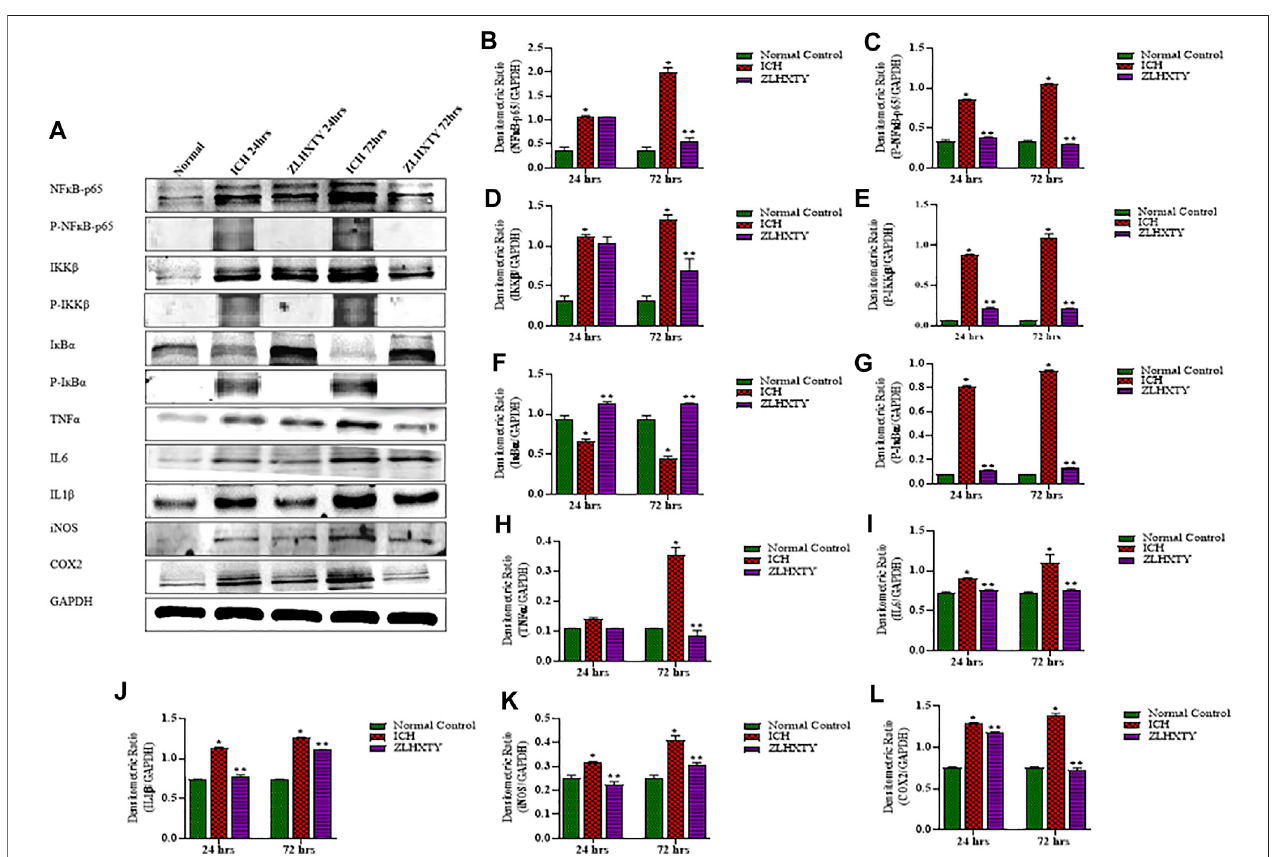
FIGURE 5 | Western blotting demonstrated ZLHXTY-HD capsule downregulated the protein expression of NF κ B signalling after ICH. (A) A representative immunoblot showing the effect of ZLHXTY-HD on protein expression of NF κ B-p65, P-NF κ B-p65, IKK β , P-IKK β , I l B α , P-I l B α , TNF α , IL6, IL1 β , iNOS, COX2 and GAPDH; (B) , the quantitative densitometric ratio of NF κ B-p65, (C) P-NF κ B-p65, (D) IKK β , (E) P-IKK β , (F) I l B α , (G) P-I l B α , (H) TNF α , (I) IL6, (J) IL1 β , (K) iNOS, and (L) COX2relativetoGAPDH.ZLHXTY-HDcapsuletreatmentreducedtheproteinexpressionofNF κ B-p65anditstargetproteinsafter24and72 h.Datarepresentthe mean ± SD, n = 3, * p < 0.05 as compared to normal control, ** p < 0.05 as compared to ICH group.